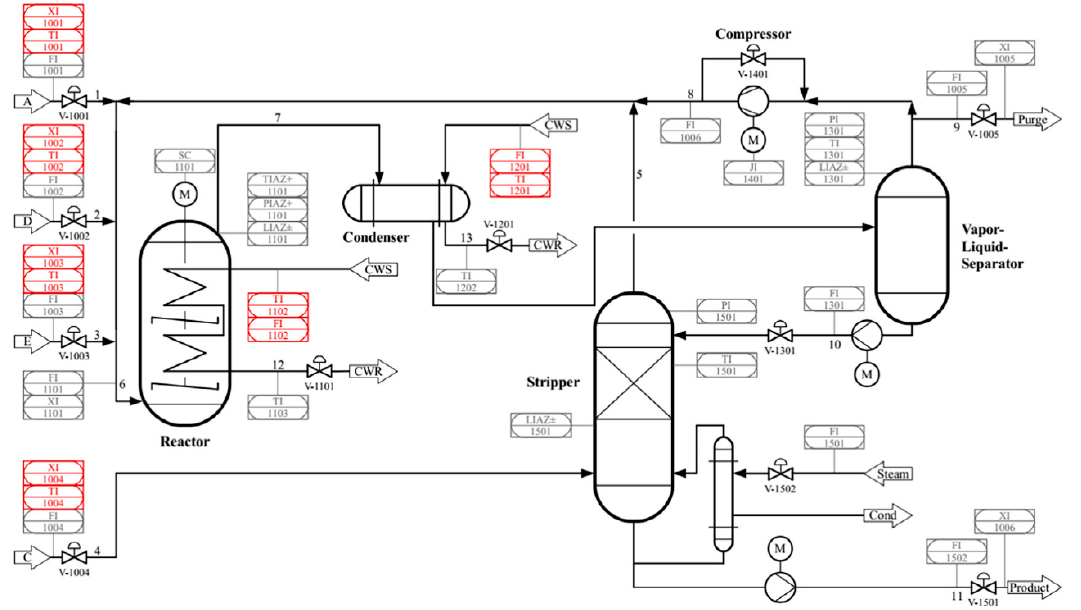
Figure 7. The Tennessee Eastman (TE) process. Table 1. Faults for the Tennessee Eastman (TE) process.